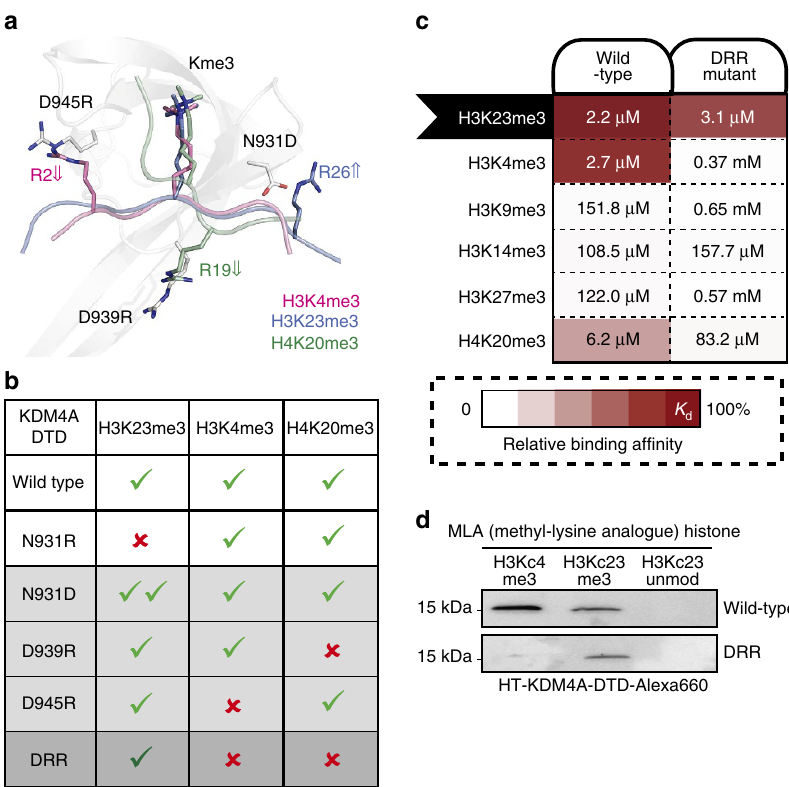
Figure 3 | H3K23me3 recognition is modulated by unique side-chain interactions. ( a , b ) Structural representation and a table summary about the side-chain interactions for trimethyl-lysine histone recognition by KDM4A-DTD: N931D increases H3R26-mediated H3K23me3 interaction, D939R decreases H4R19-mediated H4K20me3 interaction and D945R decreases H3R2-mediated H3K4me3 interaction. ( c ) Triple mutant (N931D/D939R/ D945R, or DRR) reader is specific for H3K23me3. Matrix represents pairs of KDM4 DTD proteins and trimethyl-lysine peptides (see Supplementary Table 1 for peptide information) for each fluorescence polarization assay. Relative specificity factors (as shown by the shades of red) were normalized to the tightest binding in the matrix ( K d ¼ 2.2 m M). Binding affinity for each protein-peptide combination as determined by FP is labelled. ( d ) DRR mutant fails to recognize H3Kc4me3 MLA but retains binding to H3Kc23me3 MLA histone in a far western blot